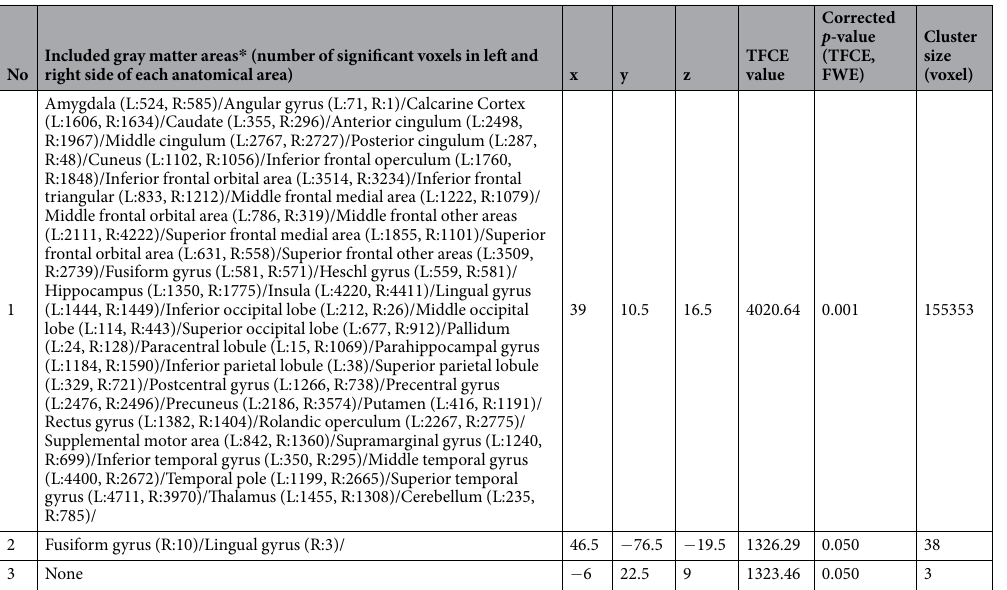
Table 6. Brain regions exhibiting significant correlations between TBIT reasoning factor scores and